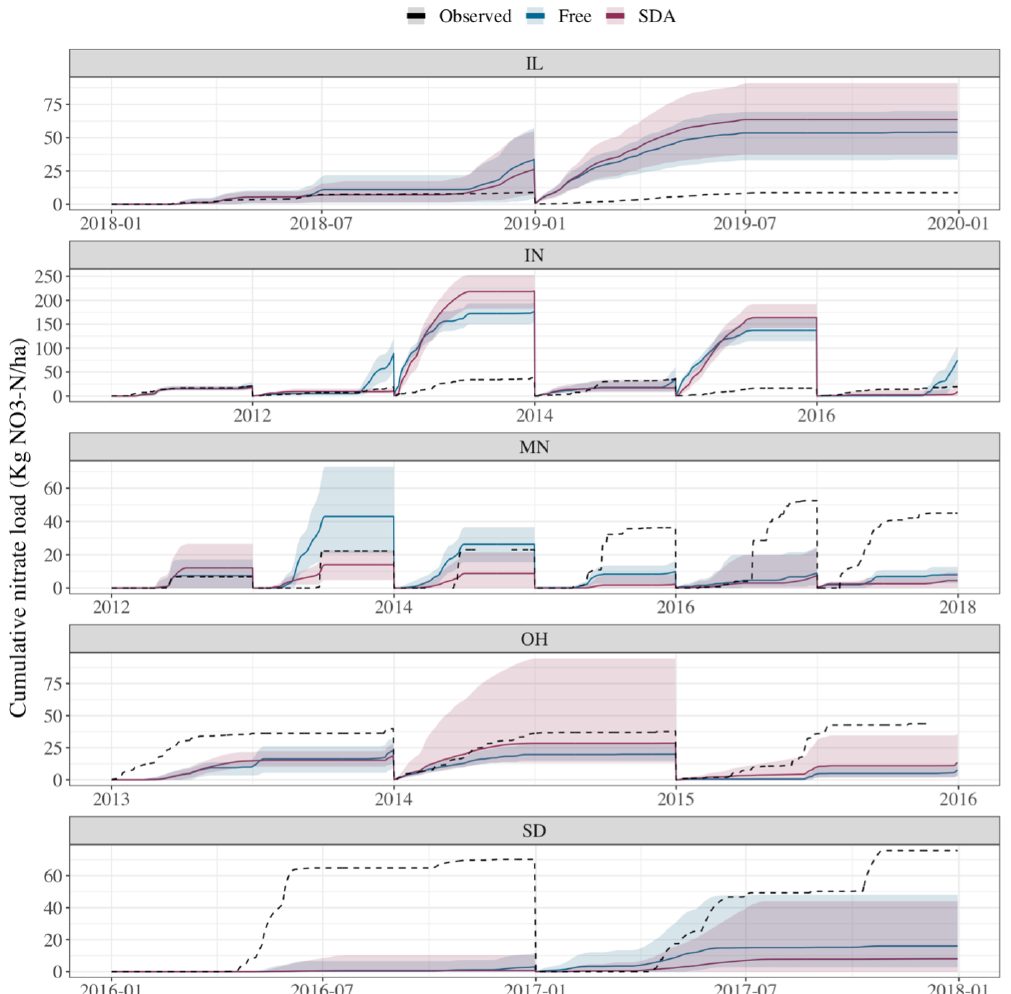
Figure A3. Time series of cumulative NO 3 load estimates from the two schemes for each site year with the mean daily estimates demonstrated with line graphs and the 95% credibility interval demonstrated by the shaded regions. Black dashed lines represent the observed cumulative value for each site